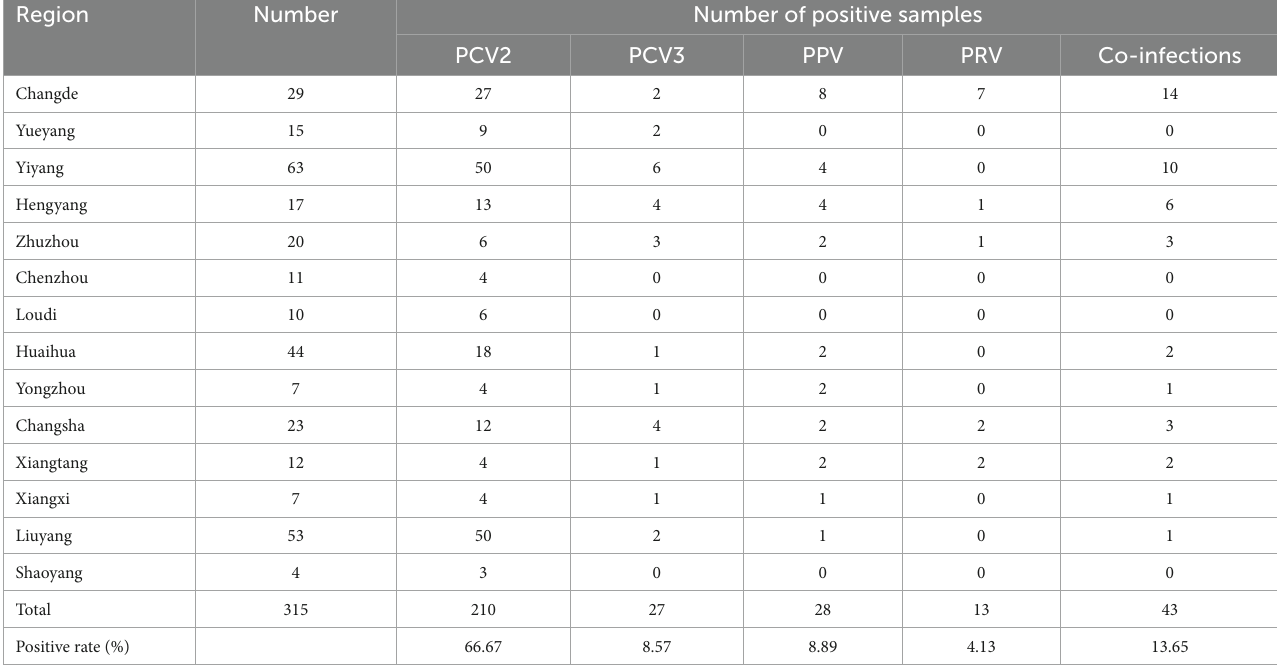
TABLE 3 Detection results of clinical samples by the multiplex real-time PCR. Region